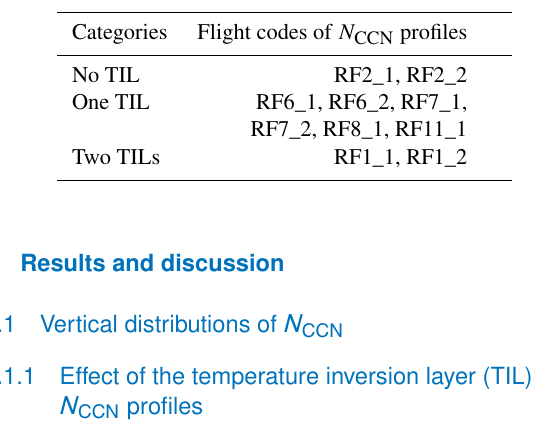
Table 3. Classification of different N CCN profiles based on the number of